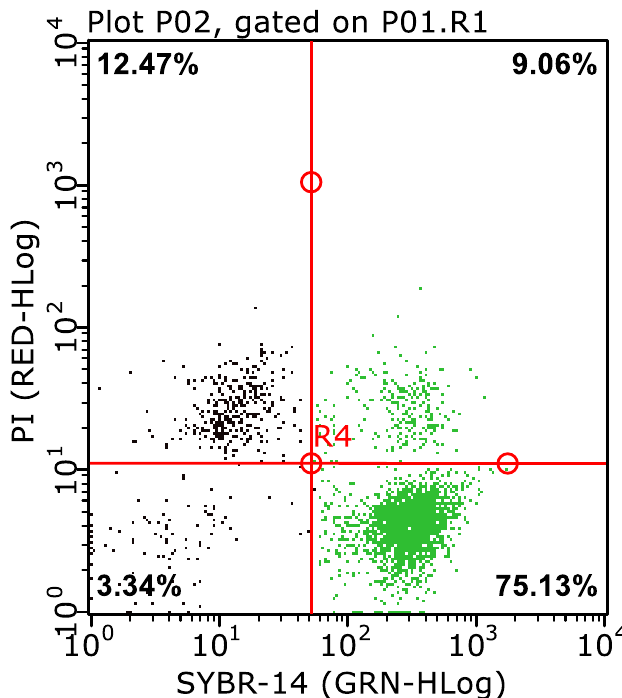
Figure 3. An example of a dot plot of live spermatozoa indicated by green dots in the Control group in the lower right quadrant (75.13%): SYBR+PI- (SYBR, SYBR-14; PI, propidium iodide).